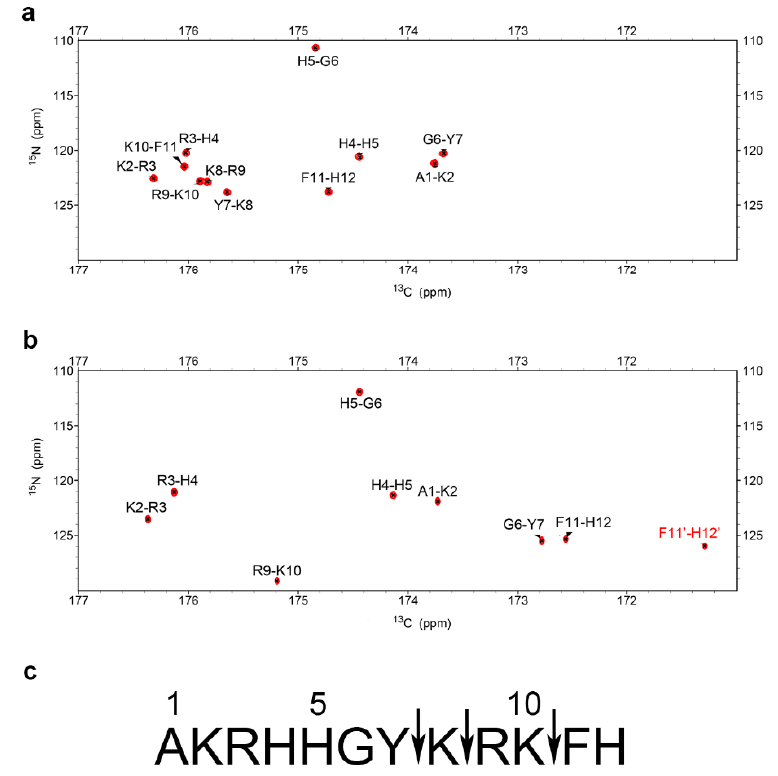
Figure 3. 15 N– 13 C CON spectra of the 0.25 mM P-113 peptides presented in ( a ) Sabouraud dextrose (SD) broth only, and ( b ) 10 7 CFU / mL of C. albicans at 301 K for 24 h. A comparison of the two spectra clearly shows that cross-peaks of Y7-R8, R8-K9, and R10-F11 were lost by degradation, indicating the cleavage sites. ( c ) C. albicans proteinase cleavage sites of P-113. Solid arrows indicate the cleavage sites.